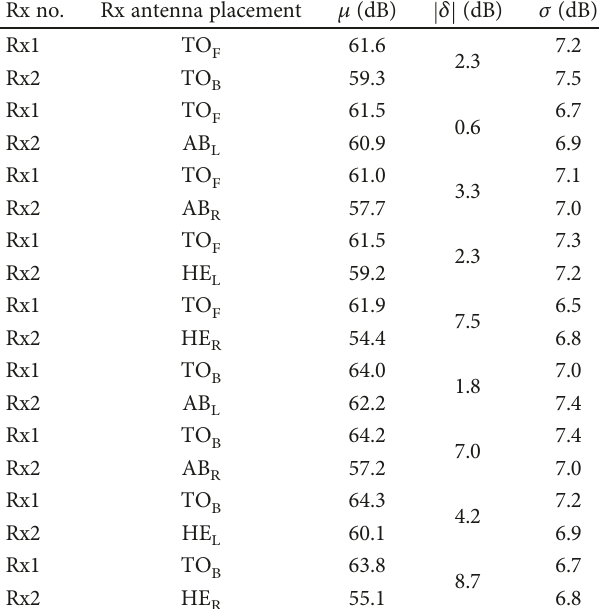
Table 2: The mean ( μ ) and standard deviation ( σ ) of system loss for di ff erent placements of the space diversity Rx antennas for a walking scenario in the o ffi ce